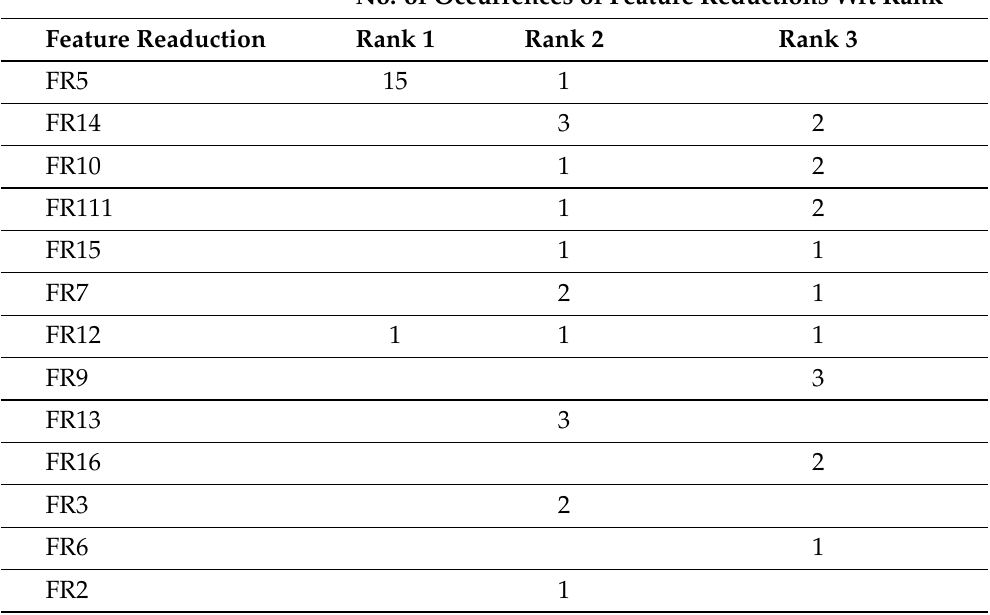
Table 10. Occurrence of Few Top-Ranking